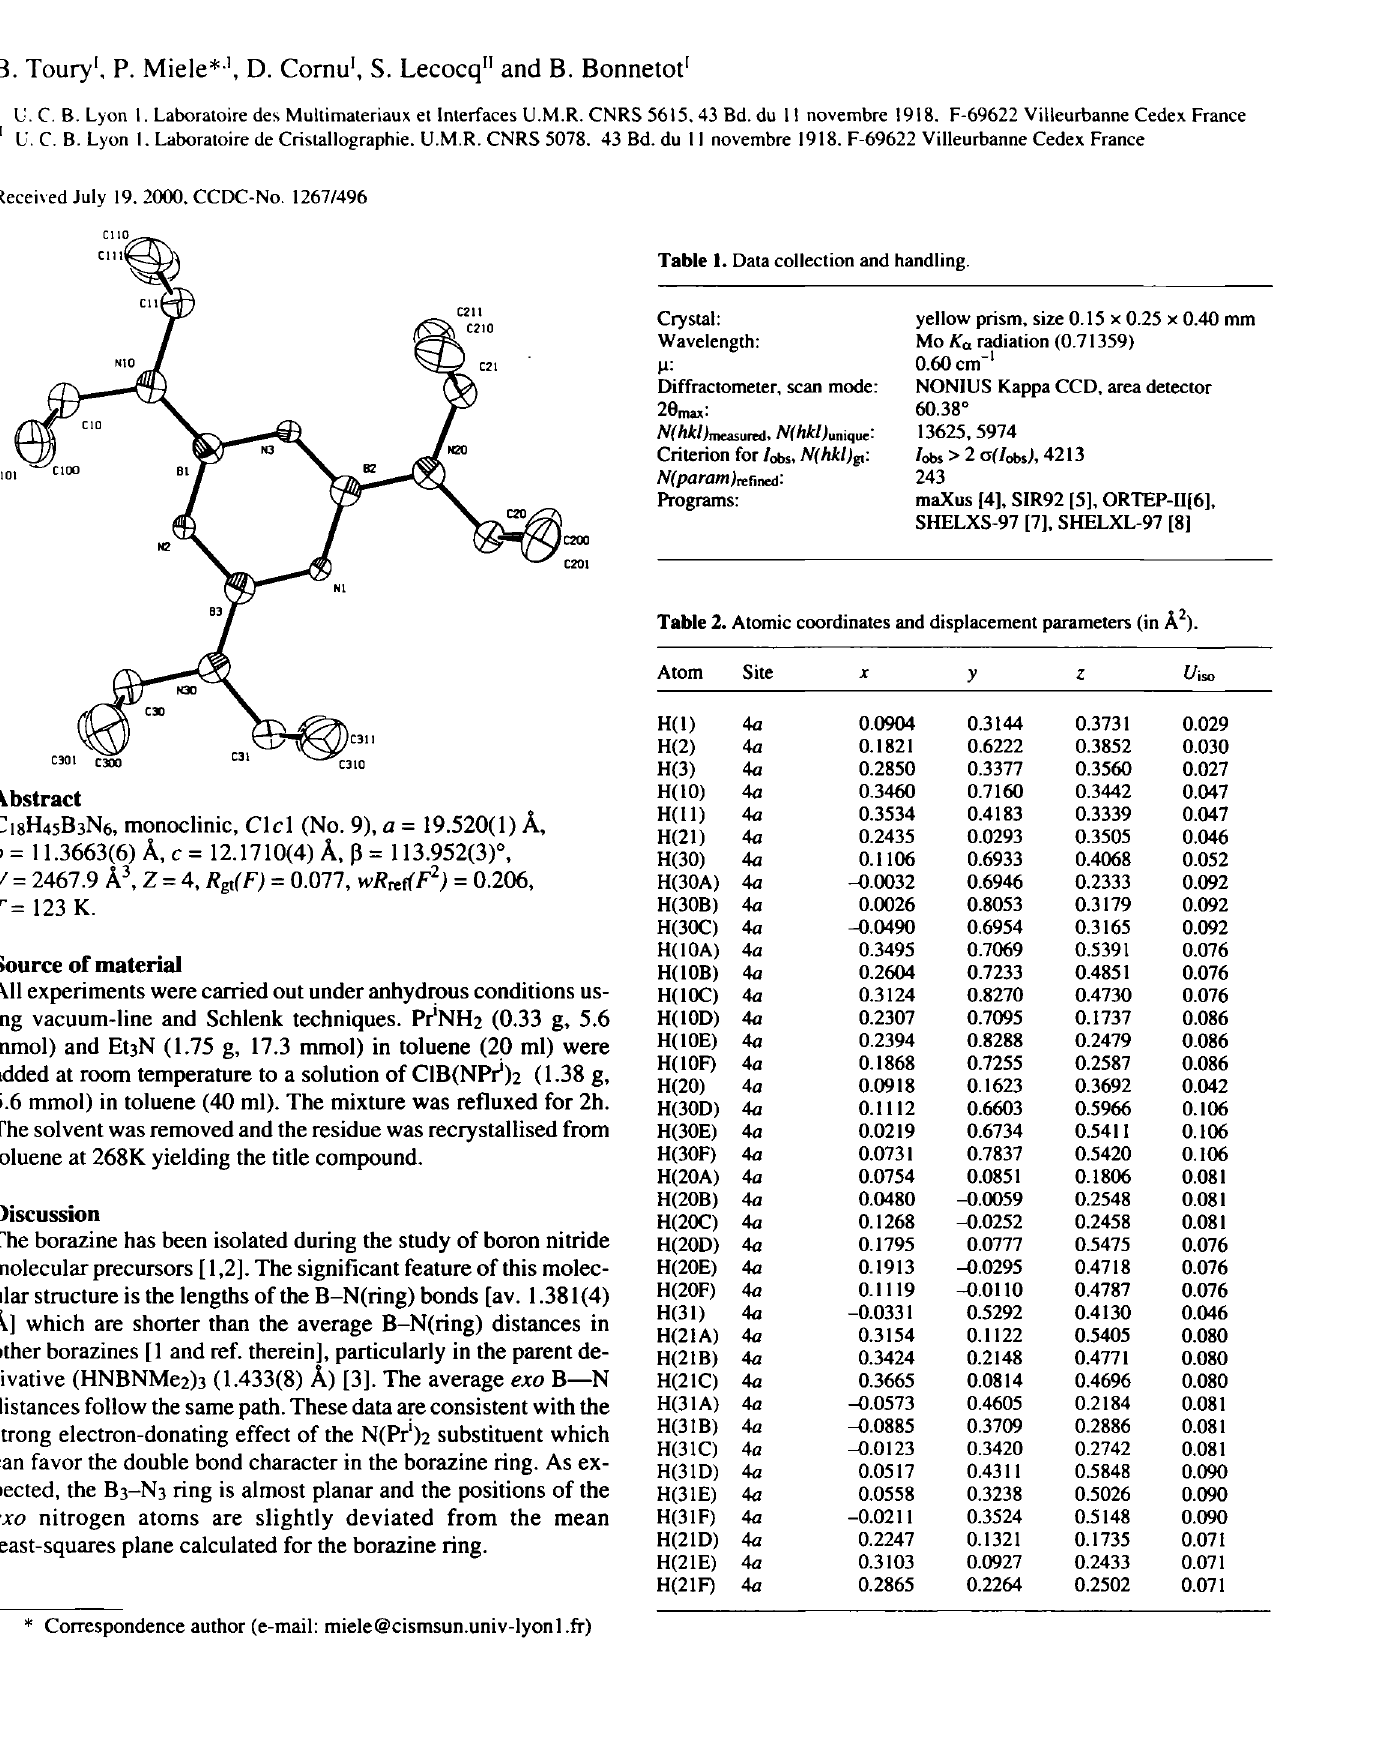
Table 1. Data collection and handling.